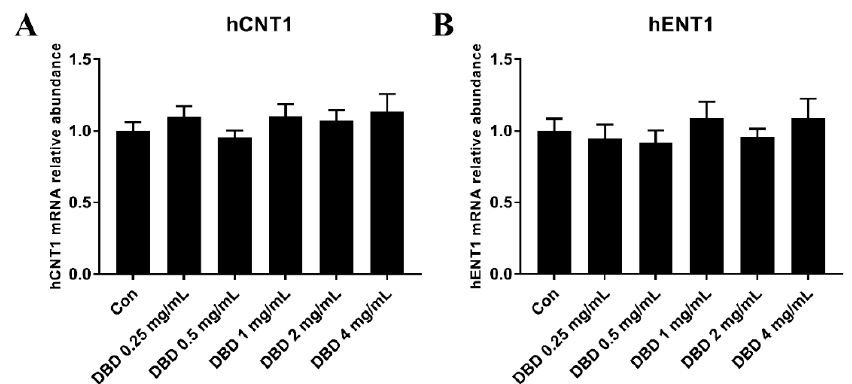
Figure 7. The mRNA expression of hCNT1 ( A ) and hENT1 ( B ) in DBD-treated A549 cells. Data were expressed as mean ± SD of four independent experiments.